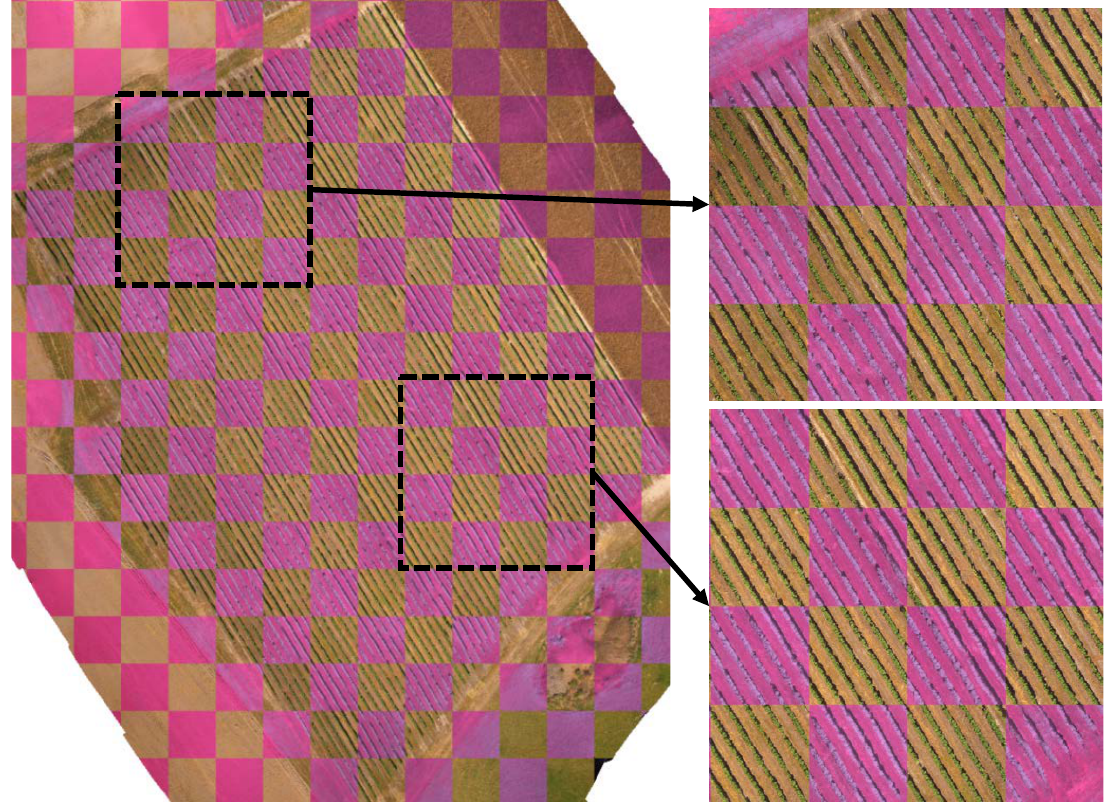
Figure 4. Qualitative results of orthophotos registration using a chessboard pattern.